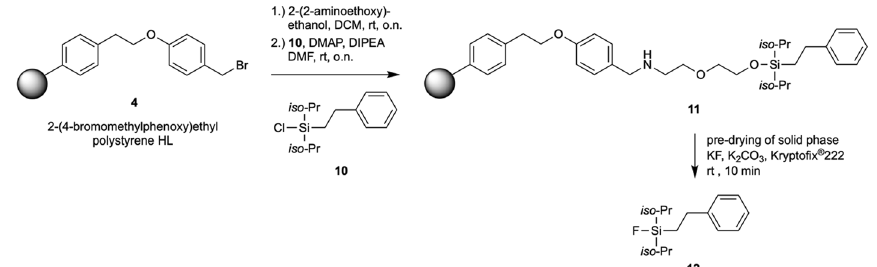
Fig. 3 Detagging of di- iso propyl silyl fluoride 12 from immobilized amino alcohol silyl ether